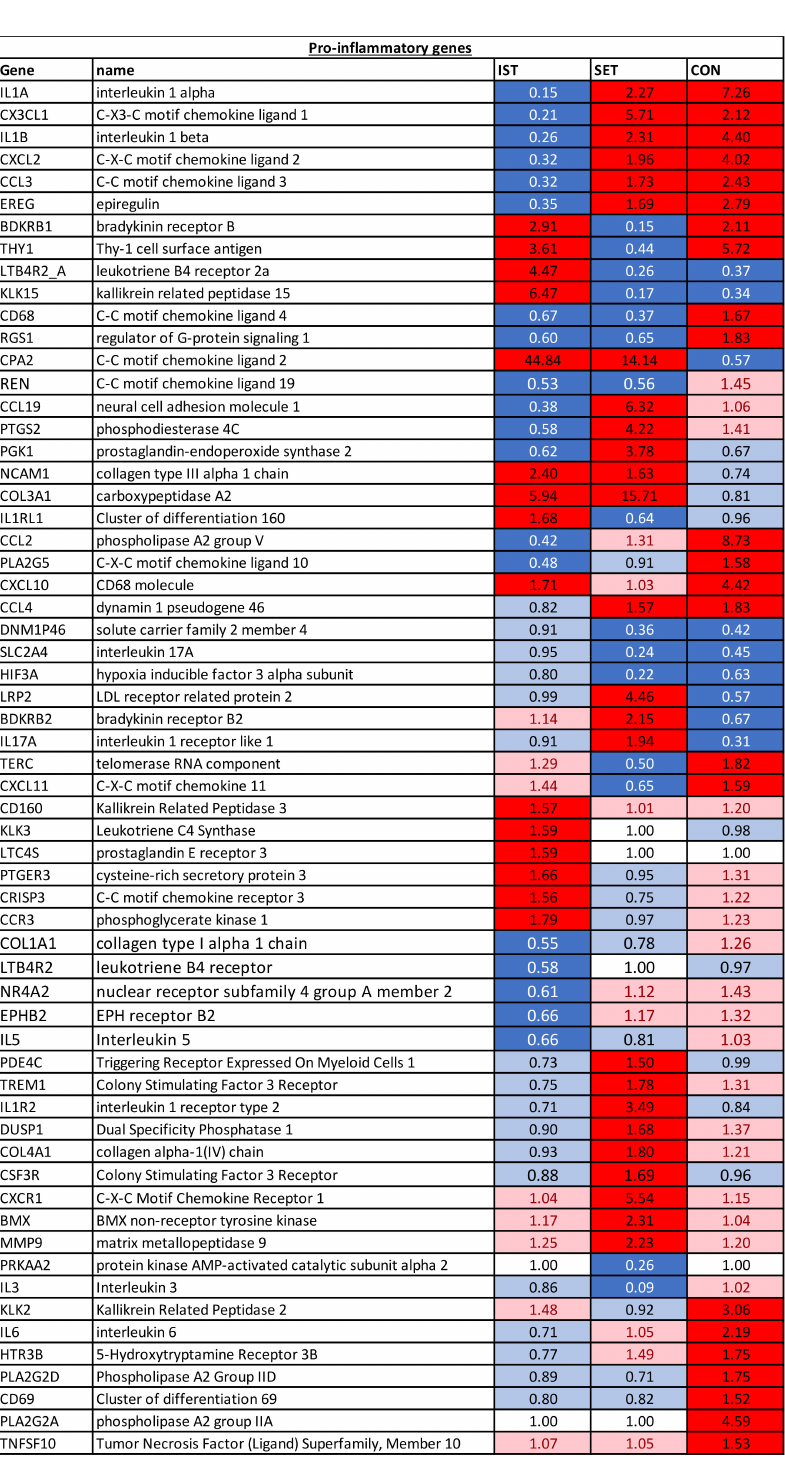
Figure 3. Pro-inflammatory genes of which the expression was changed significantly in at least one of the groups. FC of the genes represent the change from baseline to 3 months intervention. Dark blue: genes that were downregulated after the intervention (FC of ≤ 0.67). Light blue: genes showing a tendency towards downregulation after the intervention (1 > FC < 0.67). White: genes of which expression was not altered after the intervention (FC = 1); Pink: genes showing a tendency towards upregulation after the intervention (1 < FC < 1.5). Red: genes that were upregulated after the intervention (FC ≥